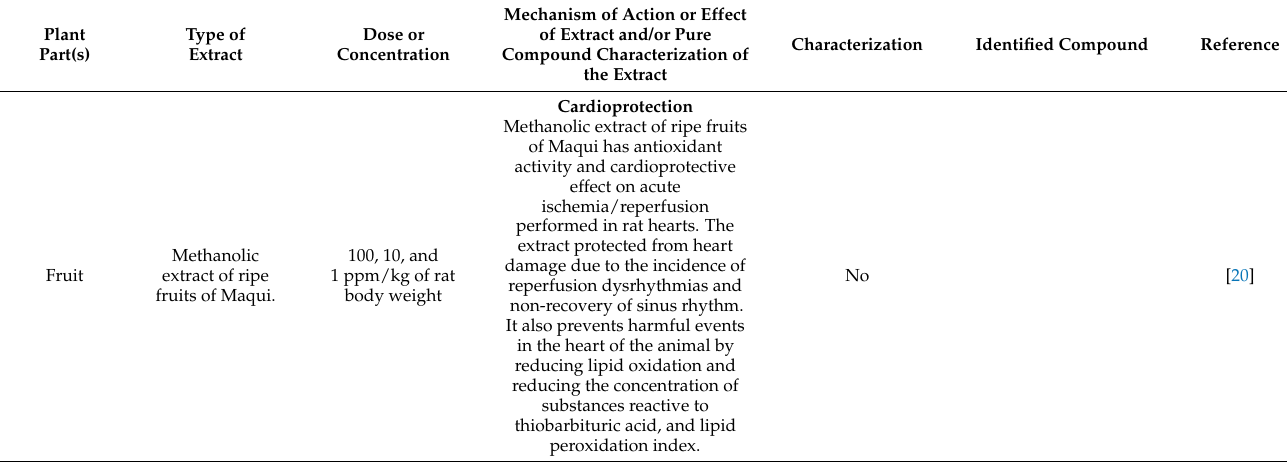
Table 2. Cardioprotective role of Maqui: clinical